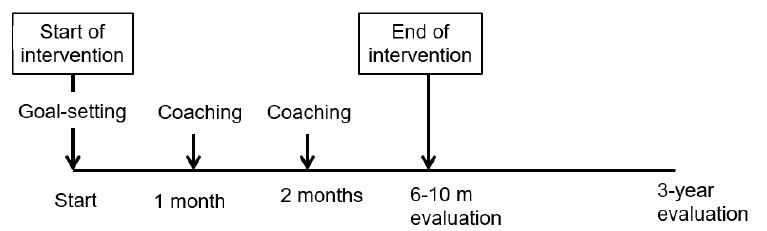
Figure 1. Timeline of the intervention and evaluation in a total of five home visits. Data collection occurred at three points (start, after 6-10 months, and 3-year follow-up). occurred at three points (start, after 6–10 months, and 3-year